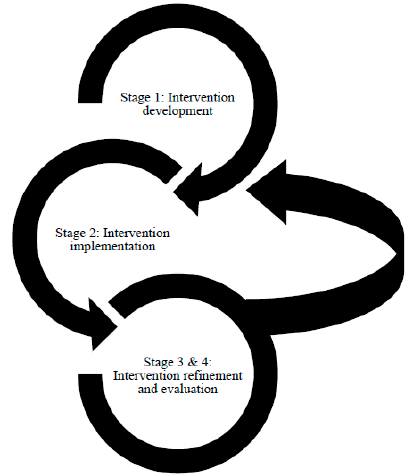
Figure 1. Processes guiding the implementation of the ATHENA intervention.